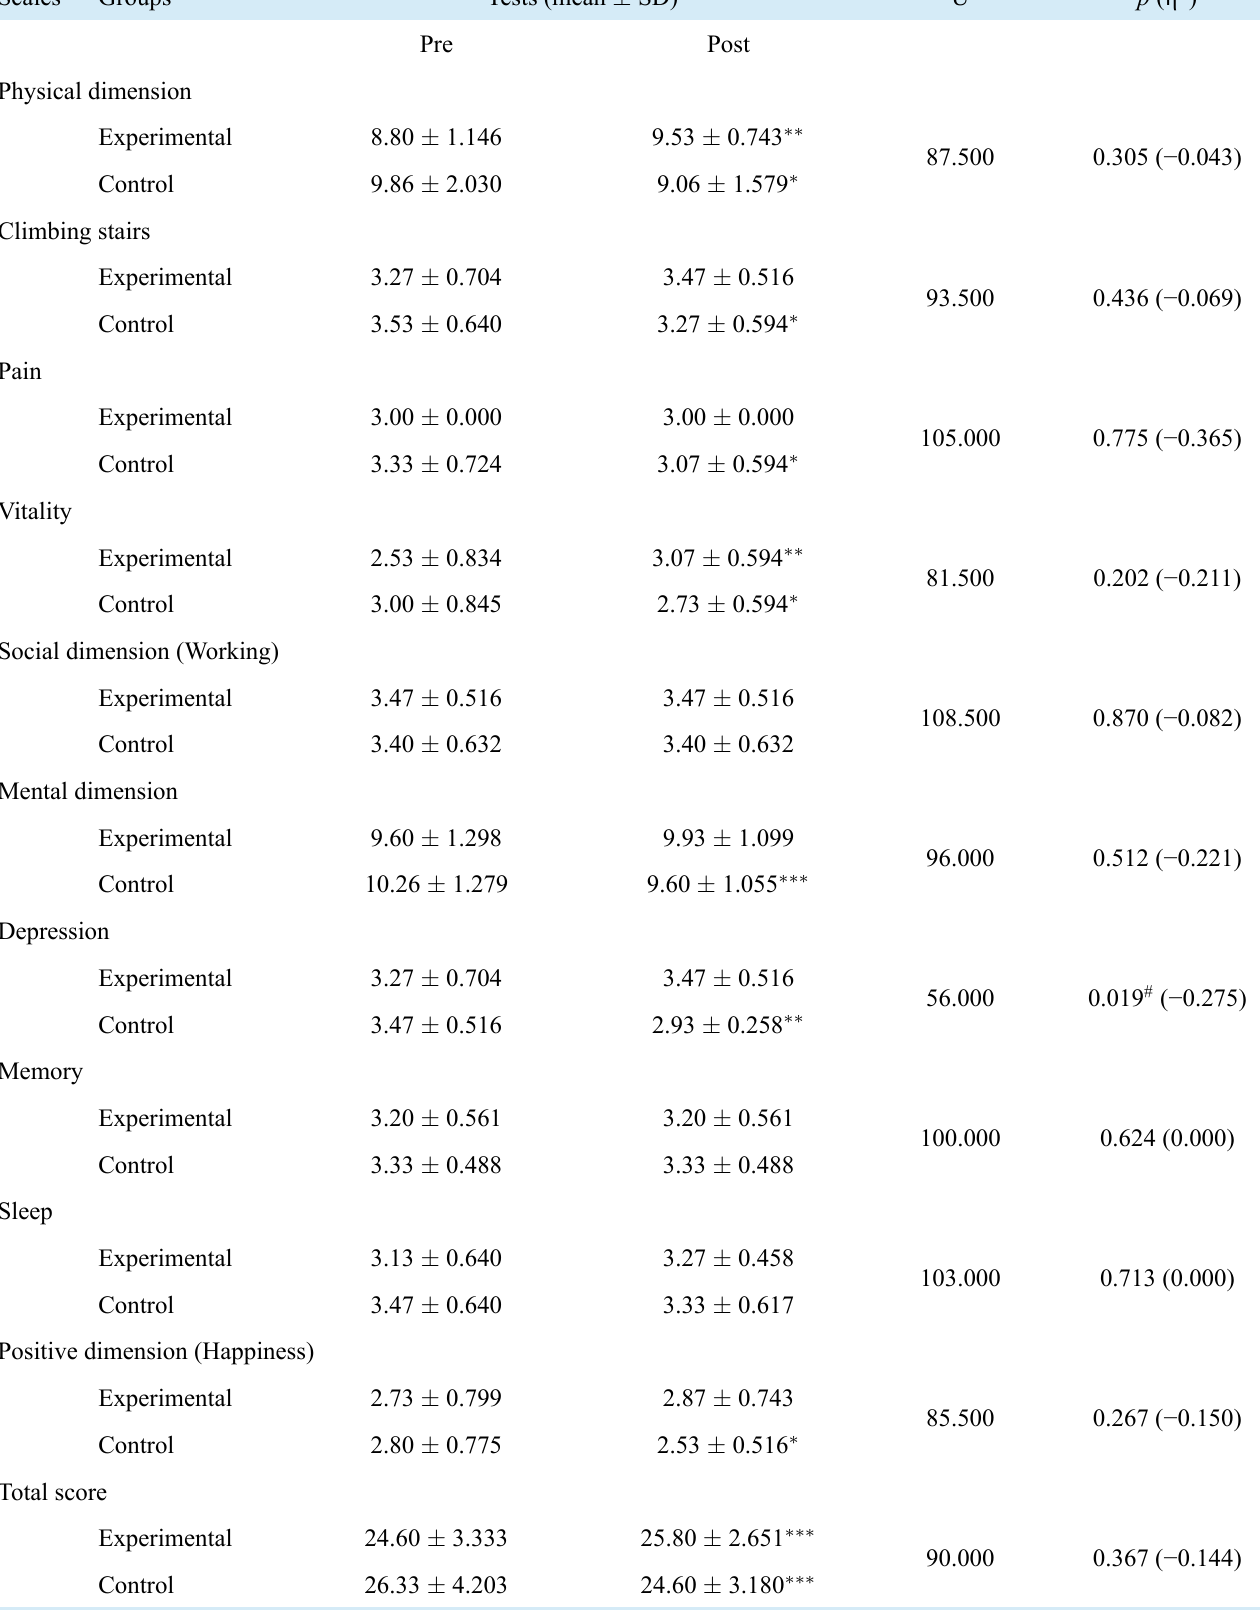
TABLE 4. Results of quality of